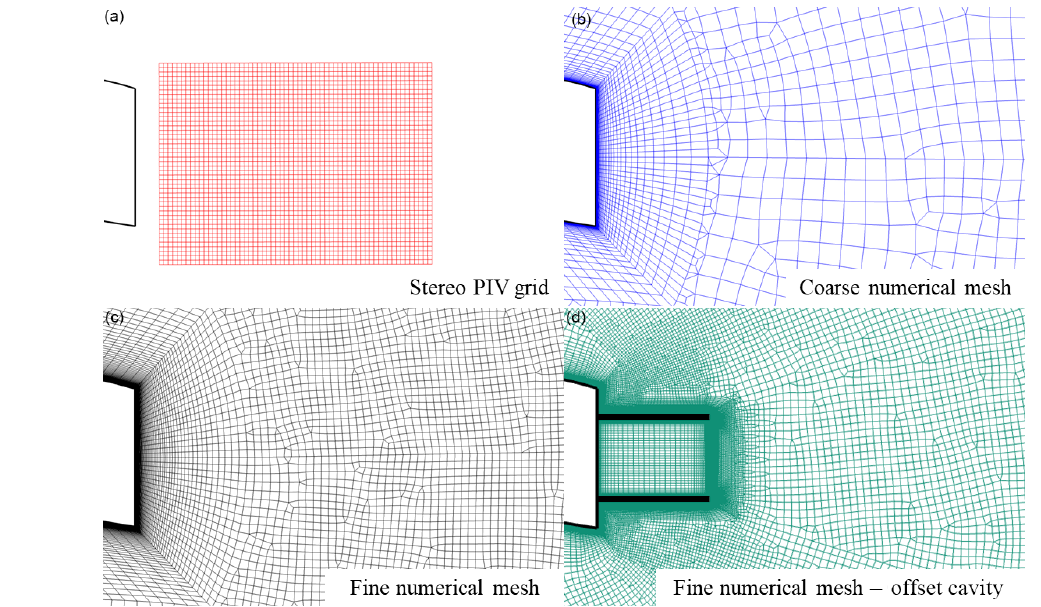
Figure 1. Details of the stereo PIV grid and the numerical meshes: (a) stereo PIV measurement grid, (b) coarse numerical mesh (5 million cells), (c) fine numerical mesh (25 million cells), and (d) fine numerical mesh for the offset cavity case (25 million cells).